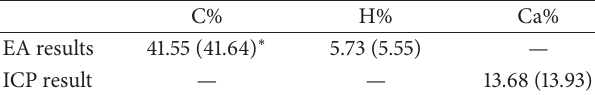
Table 2: Elemental analysis data and Ca content measured by the ICP of complex CaEt 2